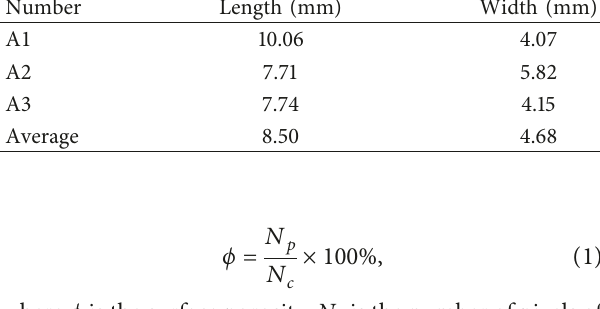
Table 3: The statistical result of the size of coal matrix.